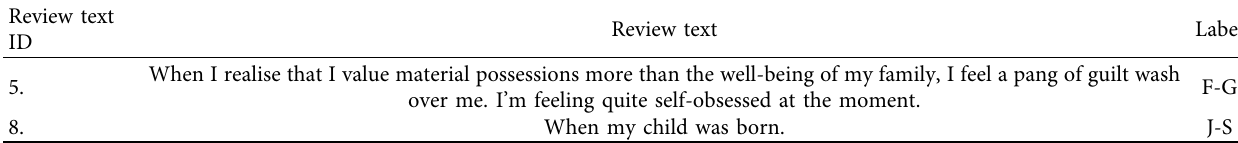
Table 1: Test set examples for emotion classification.